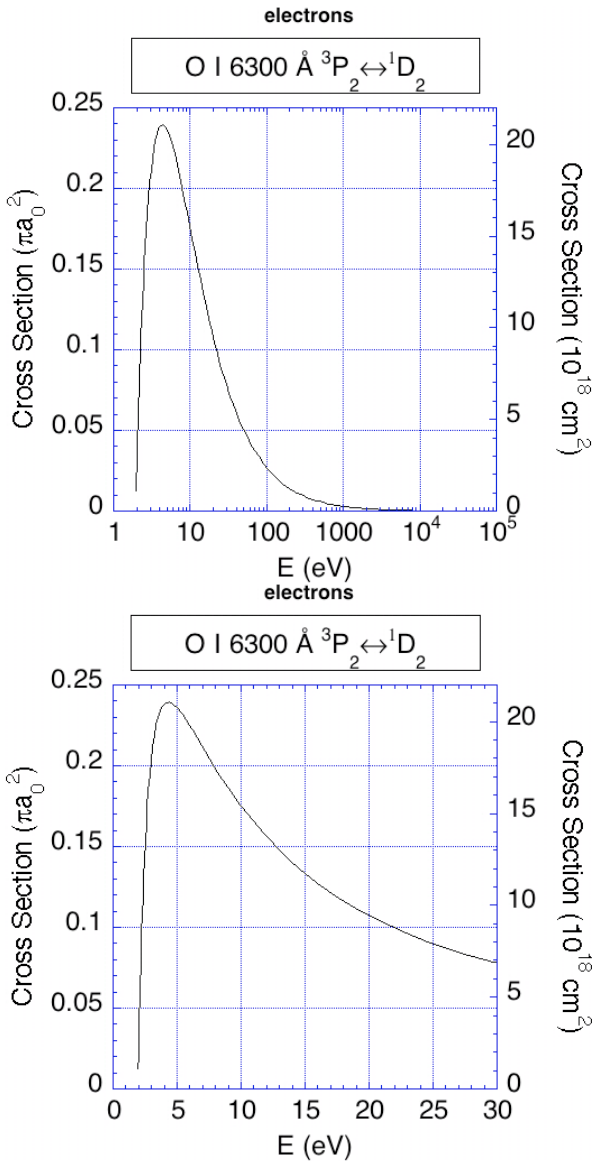
Fig. 1. Cross-section for line collisional excitation by electrons, as a function of the energy of the colliding electron. Bottom: zoom- ing in around the threshold energy, 1.967eV, for comparison with the quantum calculation result as given in Fig. 1, top left plot, of Barklem